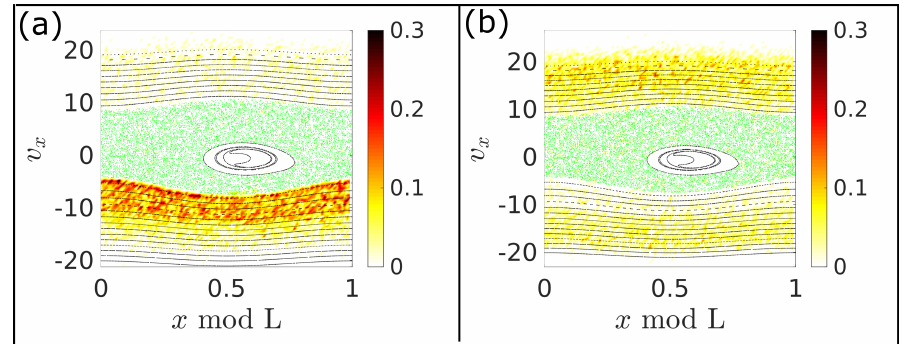
Figure 3. The asymptotic particle distribution as a function of position x mod L and v x (in colormap) of all the N = 10 4 particles propagating in the ( a ) setup II and ( b ) setup III projected on to the PSOS shown in Figure 2a. The parameters are the same as in Figure